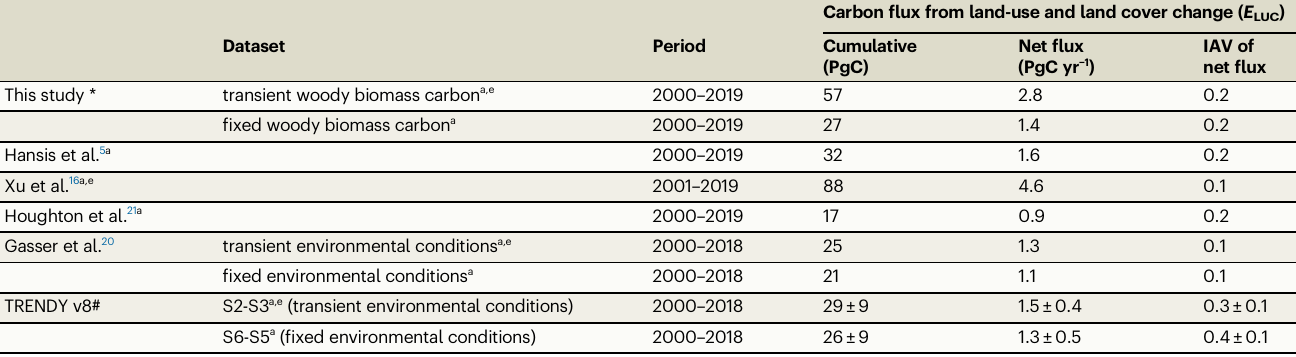
Table 2 | Comparison of estimated global carbon fl ux from land-use and (land-use induced) land cover change (positive into atmosphere) from this study compared to a range of other recent studies. Interannual variability (IAV) is calculated as the ratio of the standard deviation (SD) to the